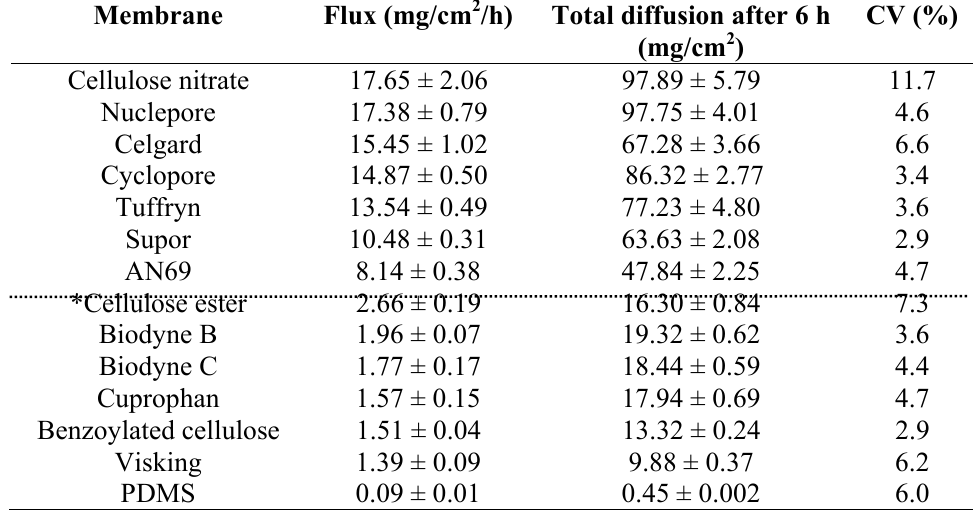
Table 3. Summary of average ibuprofen flux from saturated solution (n = 6), total diffusion after 6 h and the coefficient of variation (CV) of flux for individual synthetic membranes.